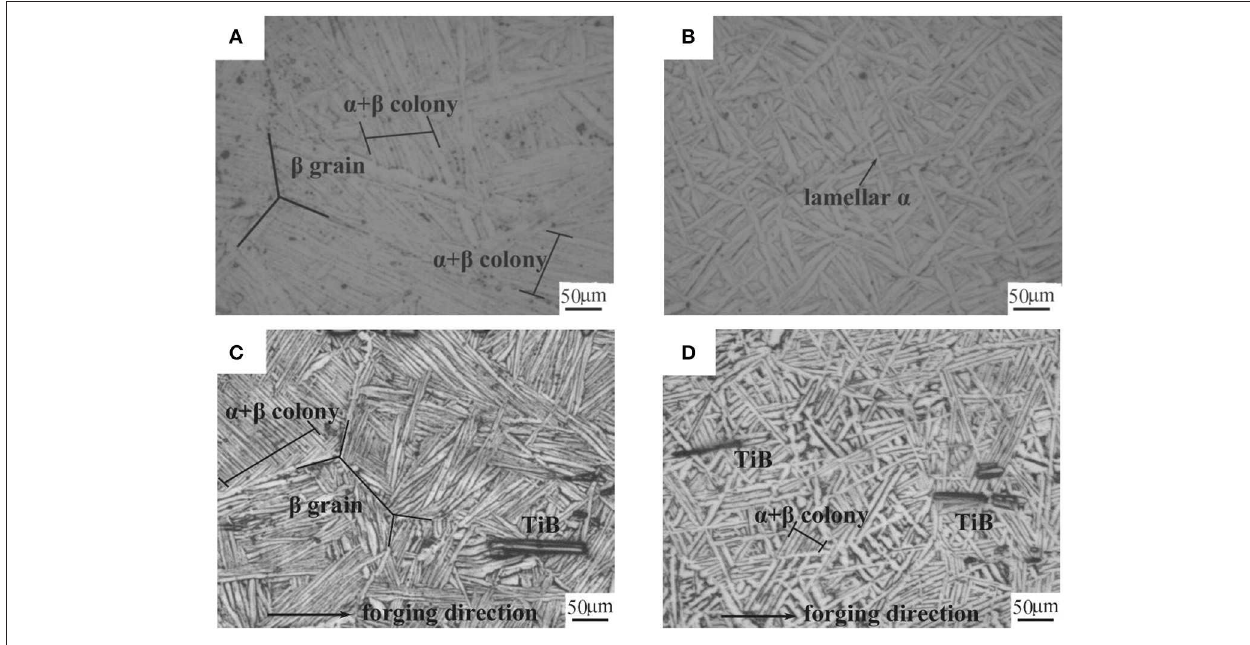
FIGURE 1 | The microstructure of specimens after heat treatment. (A) Matrix alloy, HT1. (B) Matrix alloy, HT2. (C) TMCs, HT1. (D) TMCs, HT2.